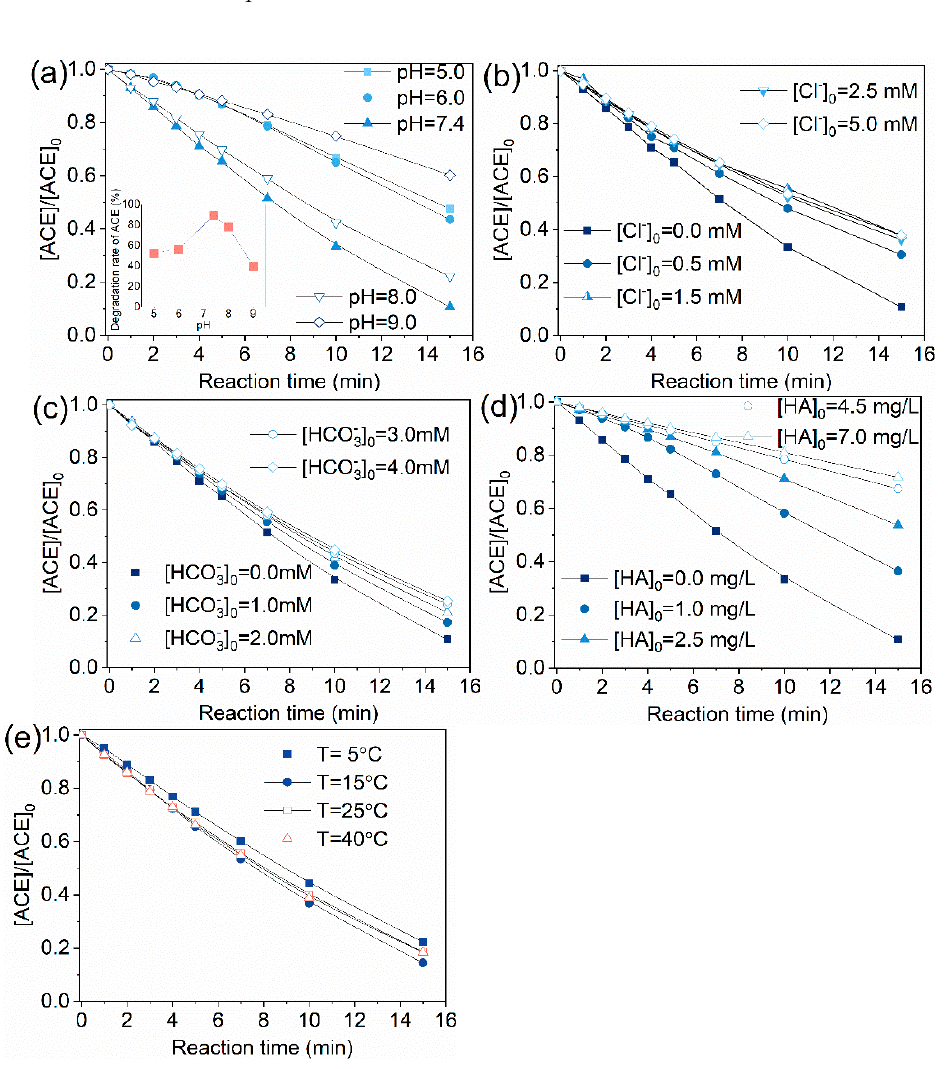
Figure 8. E ff ect of water quality parameters on the degradation of ACE using the O 3 / PMS process: Figure 8. Effect of water quality parameters on the degradation of ACE using the O 3 /PMS process: ( a ) ( a ) pH; ( b ) Cl − ; ( c ) HCO 3 − ; ( d ) HA; ( e ) temperature. Conditions: [ACE] 0 = 8.0 mg · L − 1 ; 15 ± 1 ◦ C; pH; ( b ) Cl - ; ( c ) HCO 3- ; ( d ) HA; ( e ) temperature. Conditions: [ACE] 0 = 8.0 mg  L − 1 ; 15 ± 1 °C; [PMS] 0 = [PMS] 0 = 0.4 mM; O 3 solution dosing rate 1.25 ± 0.1 µ M · min − 1 (60 ± 5 µ g · min − 1 0.4 mM; O 3 solution dosing rate 1.25 ± 0.1 µM·min − 1 (60 ± 5 µg·min − 1 ).